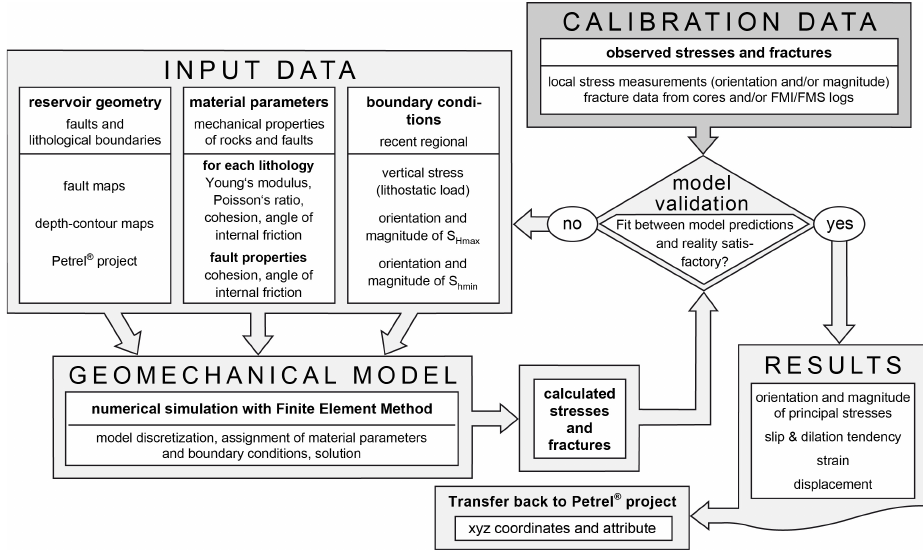
Fig. 1. Summary of the workflow used to build 3-D geomechanical FE models. Data that are applied as input must not be used for calibration purposes to avoid circular